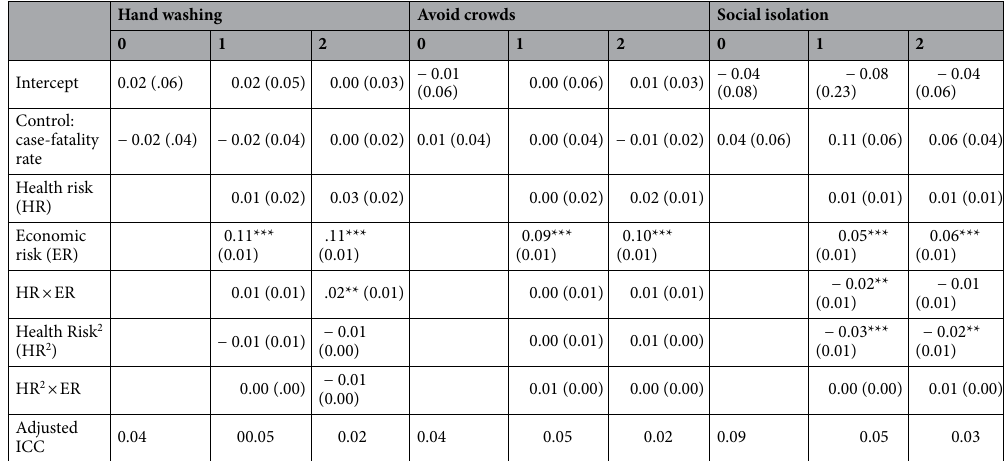
Table 1. Multilevel regression modeling: preventive health behaviors. Reporting unstandardized coefficients, standard errors in parentheses. * p < .05, ** p < .01, *** p < .001. All predictors are presented in the “Materials and methods" section and detailed in Table S1. All models controlled for COVID-19 case-fatality rate: total COVID-19 deaths per million/total COVID-19 cases per million. Model 2 adjusted for individual and country level covariates as follows. Individual level covariates: (1) direct exposure to someone in their personal network (self, family, friends) infected with COVID-19; (2) perceived knowledge about the COVID-19, (3) perceived knowledge about the economic consequences of the COVID-19; (4) the perceived quality of the public messages received, (5) community norms about mitigation measures, and (6) sociodemographic variables (age, gender, education, employment and financial status). Country-level covariates included (1) total population of the country (in millions), (2) gross domestic product (GDP) per capita (in current $US), (3) unemployment rate estimates for 2020 (as % of the labor force), (4) old age dependency ratio (%), (5) Gini Index, (6) general health expenditure (as %GDP), (7) private health expenditure (as % health expenditure), (8) out-of-pocket health payments (as % health expenditure), (9) number of hospital beds (per 1000 people).